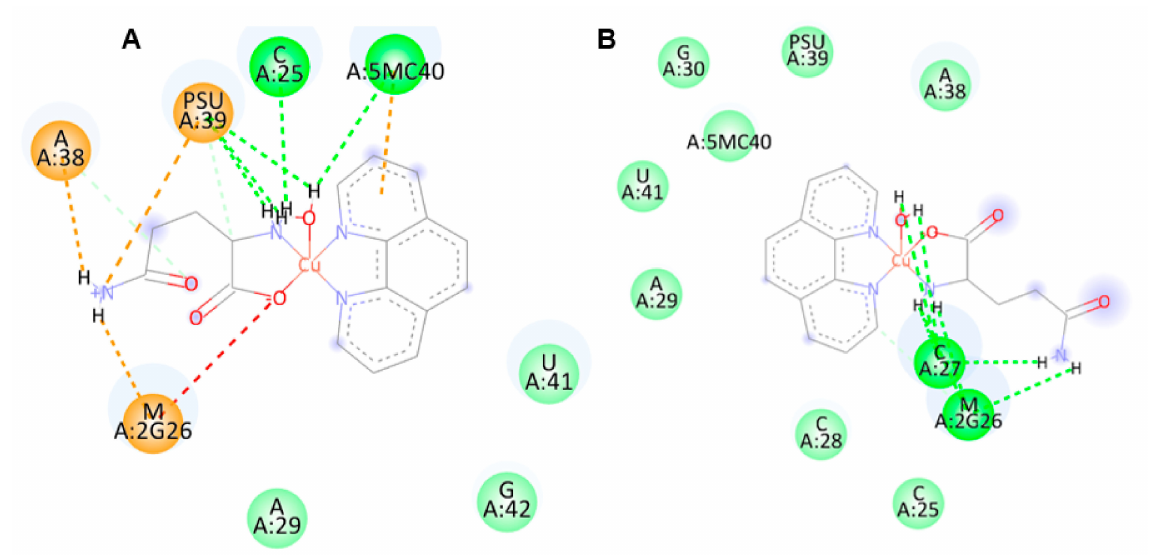
Figure 10. Interactions of Compound 1 and tRNA (6TNA). ( A ): L-syn and ( B ): L-anti. The orange dashes represent the attractive charge and the salt bridge interactions. The conventional hydrogen bonds are represented by green dashes, while light green spheres show the van der Waals